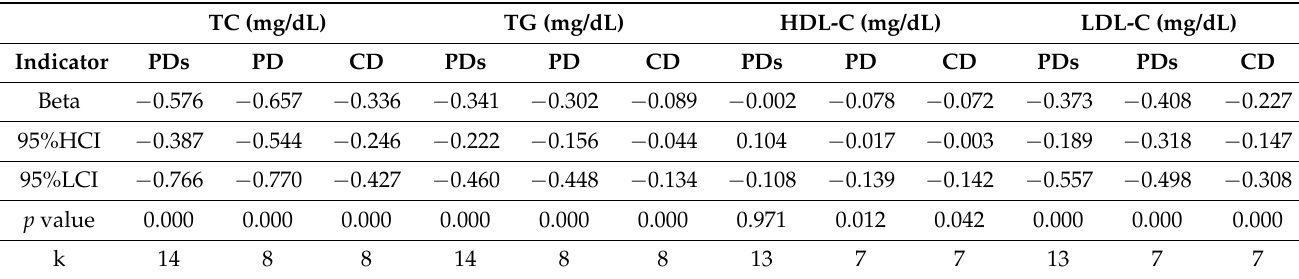
Table 4. Changes in lipid profile (total cholesterol, triglycerides, HDL-C, and LDL-C) in short-term PDs, PD, and CD studies (up to 6 months).